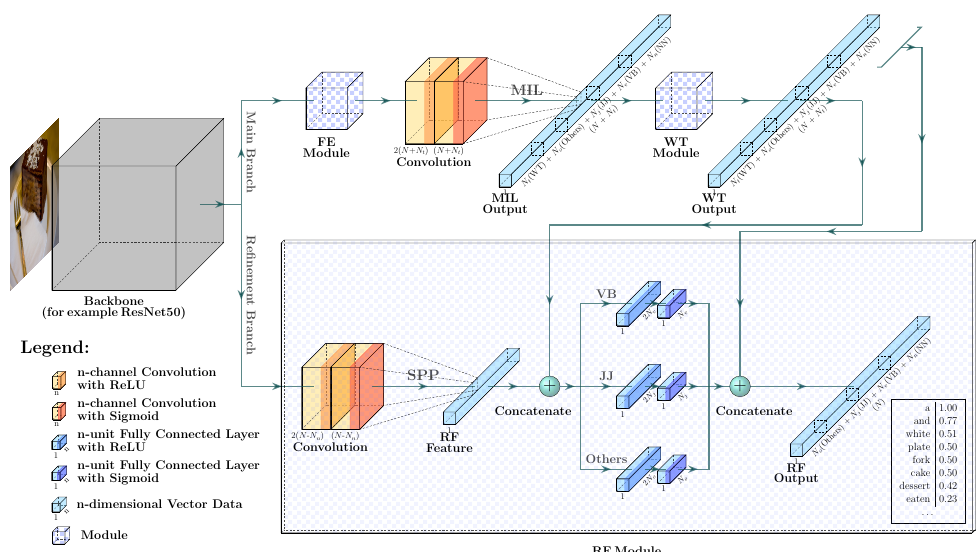
Figure 1. The network structure of our proposed Refined Universal Detection (RUDet). The main branch detects attributes using the Feature Enhancement (FE) module, the convolutional layers, the Multiple Instance Learning (MIL) method, and the Word Tree (WT) module. The Refinement (RF) module in the refinement branch integrates the visual features extracted by the Spatial Pyramid Pooling (SPP) layer and the attributes from the main branch, and then it learns a non-linear mapping to refined attributes for words of each non-nominal part of speech (POS), including verbs (VB), adjectives (JJ), and